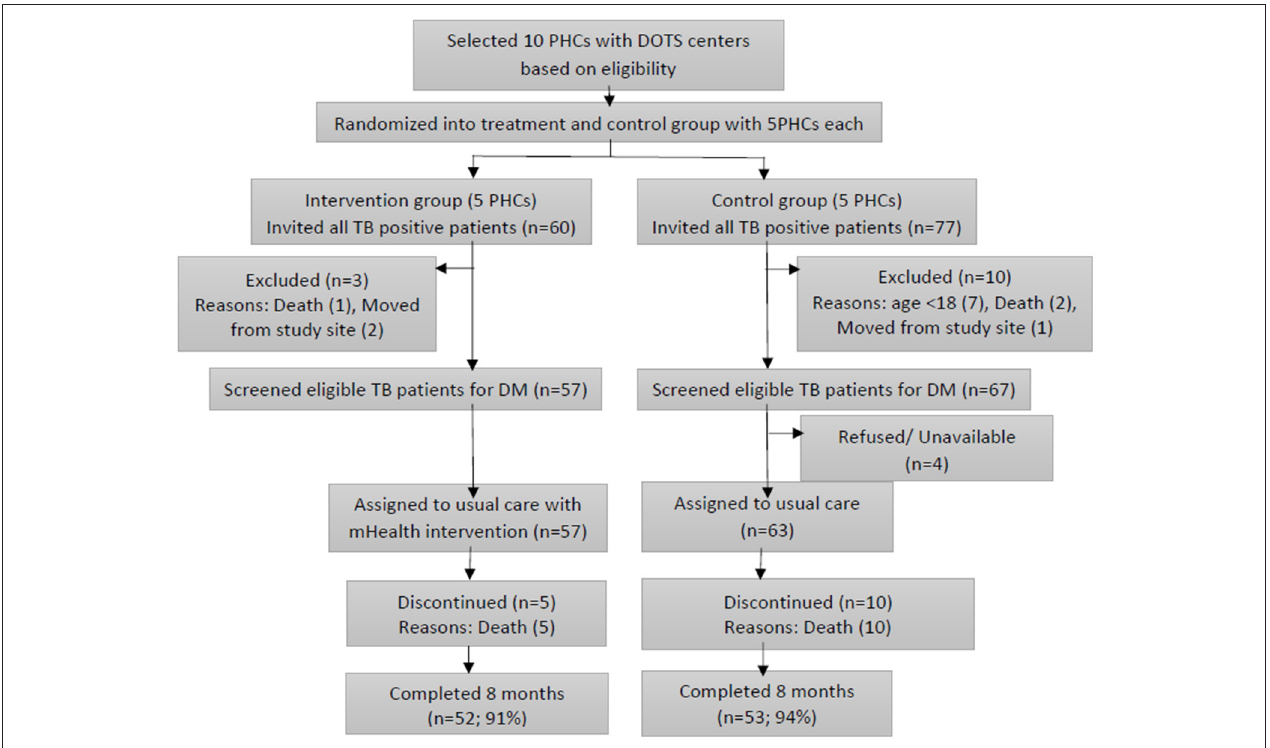
FIGURE 1 | Flowchart of study